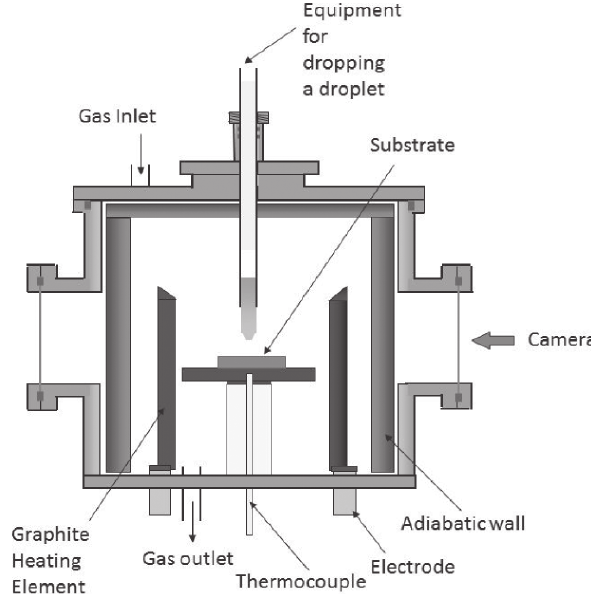
Fig. 2: Graph of the experimental setup for experiments type